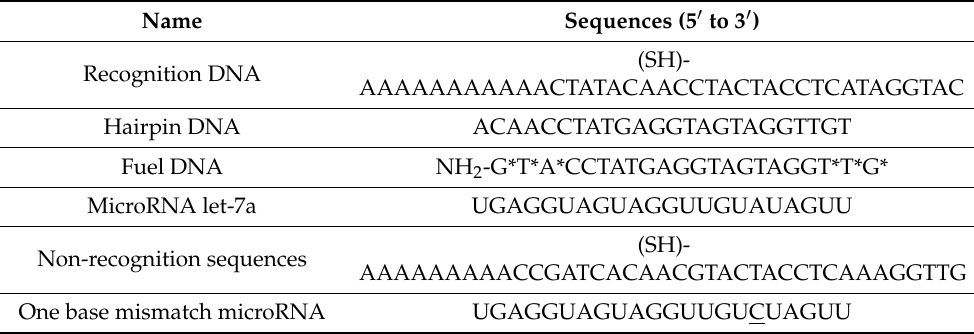
Table 1. Nucleic acid sequences used in this